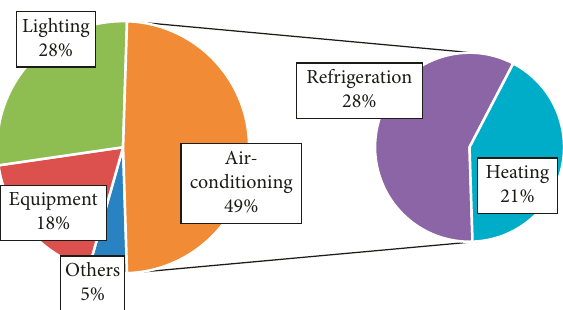
Figure 7: Percentage distribution of the building energy